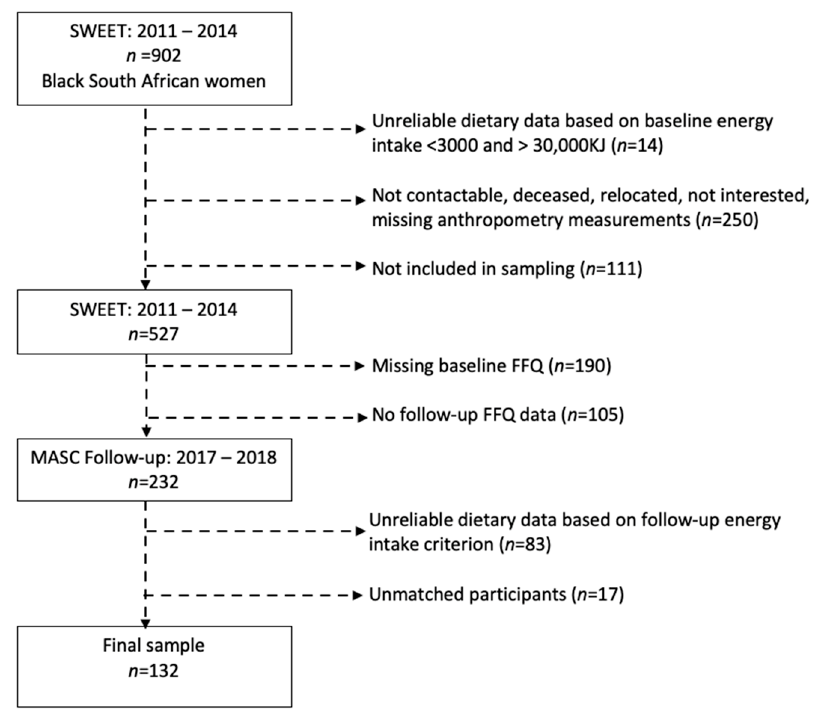
Figure 1. Flow chart of study participants. (SWEET = Study of Women in and Entering Endocrine Transition; MASC = Middle ‐ aged Soweto Cohort).